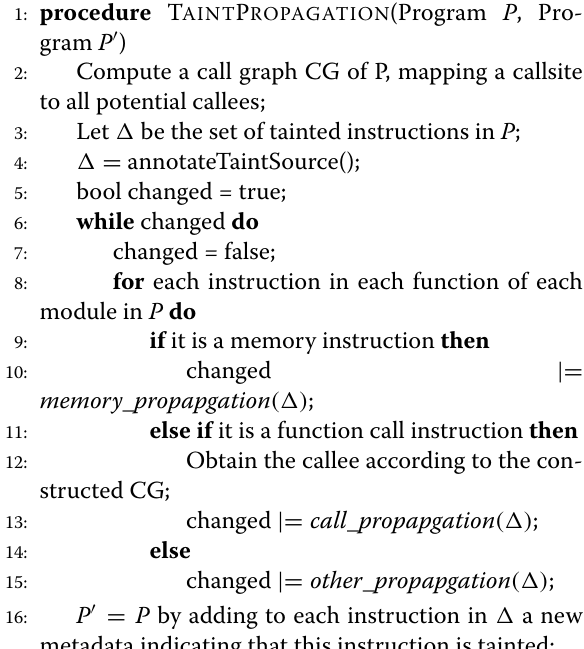
Algorithm 1 Taint propagation